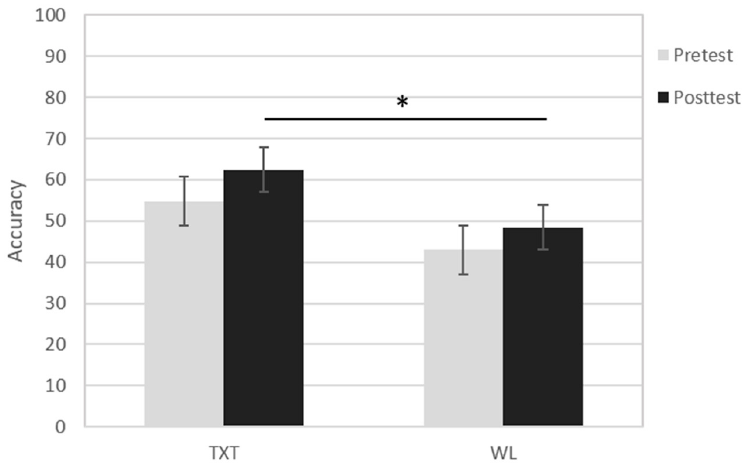
Figure 2. Mean NoGo accuracy at pre-test and post-test in treatment (TXT) and Waitlist (WL) groups. * signifies p <